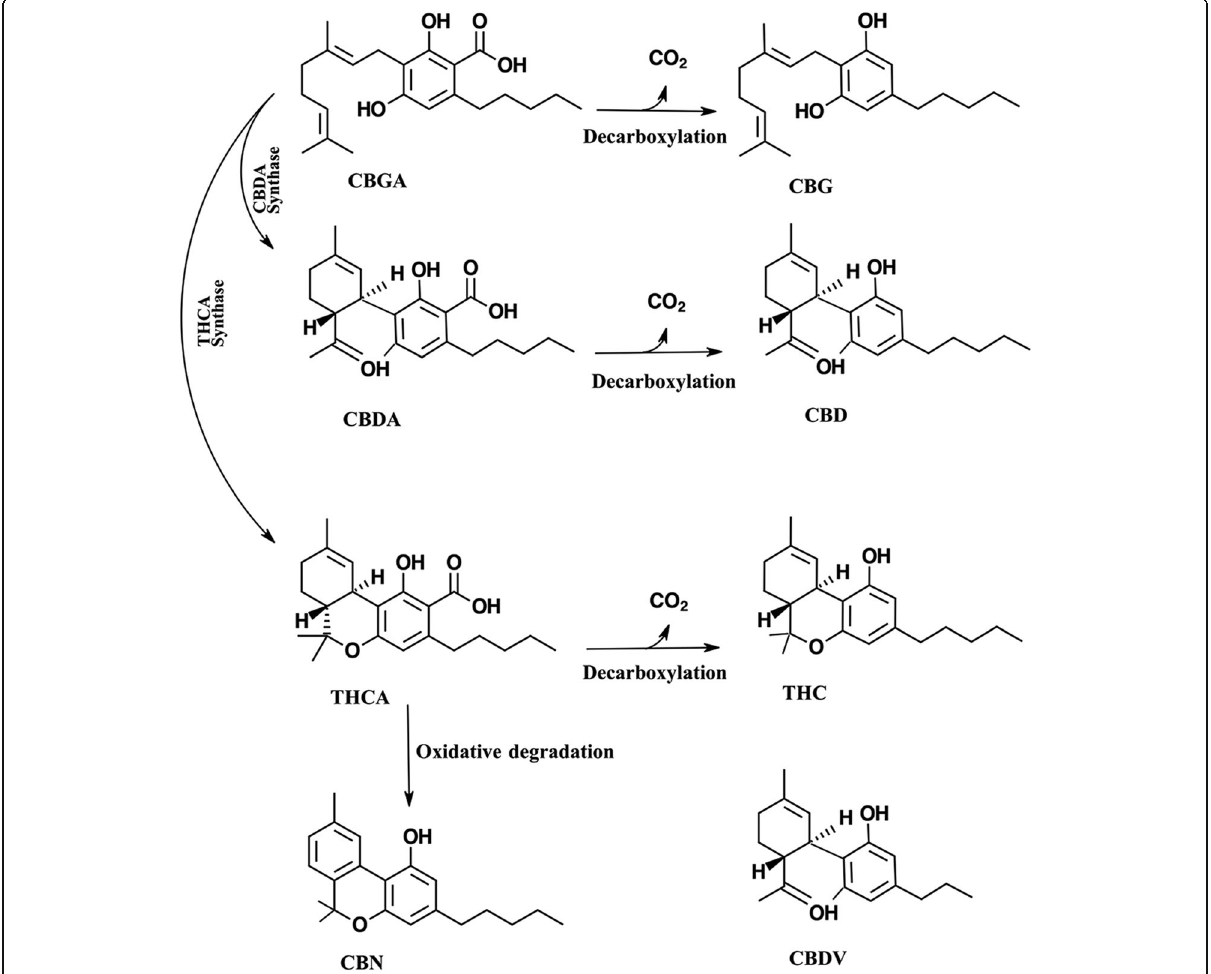
Fig. 1 The most common cannabinoids and their conversion pathway by decarboxylation because of heat or aging. C BGA can convert to CBDA and THCA by CBDA synthase and THCA synthase, respectively. CBGA: cannabigerolic acid, CBG: cannabigerol, CBDA: cannabidiolic acid, CBD: cannabidiol, THCA: tetrahydrocannabinolic acid, THC: tetrahyrocannabinol, CBN: cannabinol ( Fathordoobady et al. 2019